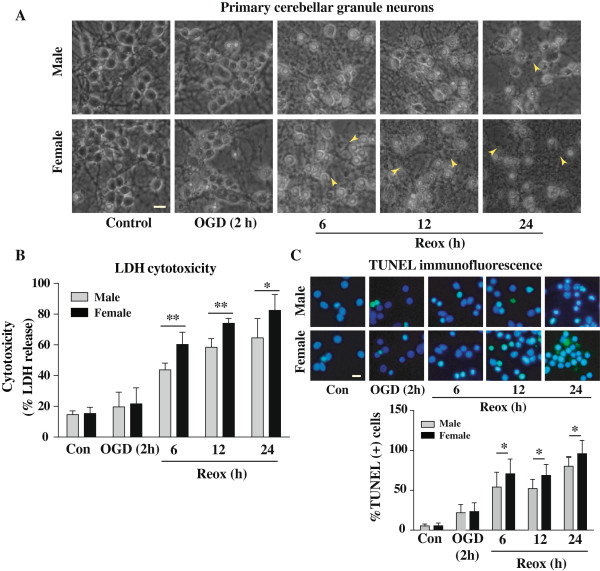
Sex-related difference in OGD- and OGD/Reox-induced neuronal death in XY and XX CGNs. The cells were exposed to OGD for 2 h or 2 h OGD followed by 6, 12 and 24 h of Reox. A) Morphological evidence of injury in XY compared to that in XX CGNs. A higher magnitude of cell injury was observed in XX CGNs. Degenerated neurons characteristics of apoptosis are shown by yellow arrow head. Scale bar 20 μm. B) Quantification of cell death by LDH release also revealed significantly higher percentage of cell death in female as compared with male CGNs after 6,12 and 24 h Reox following 2 h of OGD. Values are mean ± SD (n = 4), *p < 0.05, **p < 0.01, XX vs. XY, ANOVA followed by Bonferroni/Dunn post hoc test. C) Fluorometric TUNEL immunostaining (green) of CGNs exposed to OGD (2 h)/Reox (6,12 and 24 h) showed significantly enhanced TUNEL (+) cells in XX CGNs during the Reox periods as compared to that observed in XY CGNs (*p < 0.05). Representative images are shown. Scale bar 20 μm.